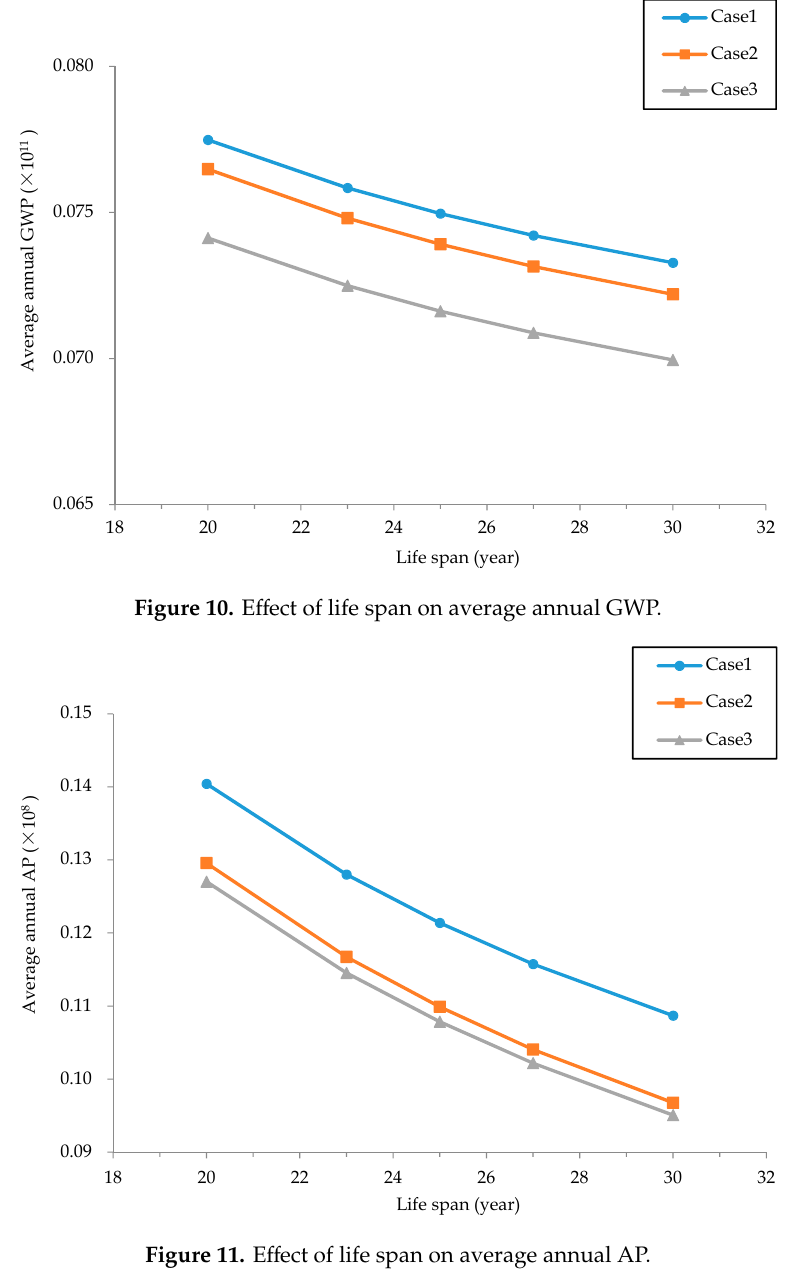
Figure 11. E ff ect of life span on average annual Figure 11. Effect of life span on average annual AP . Figure 11. Effect of life span on average annual AP .